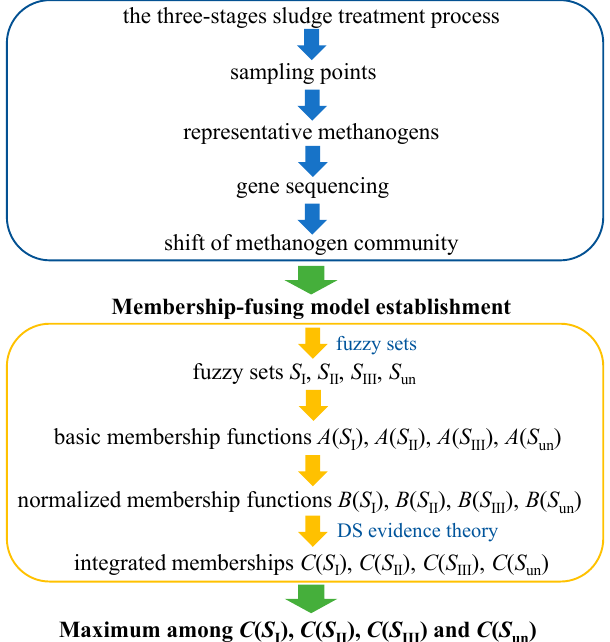
Figure 1. Procedure to build the membership-fusing model. 138